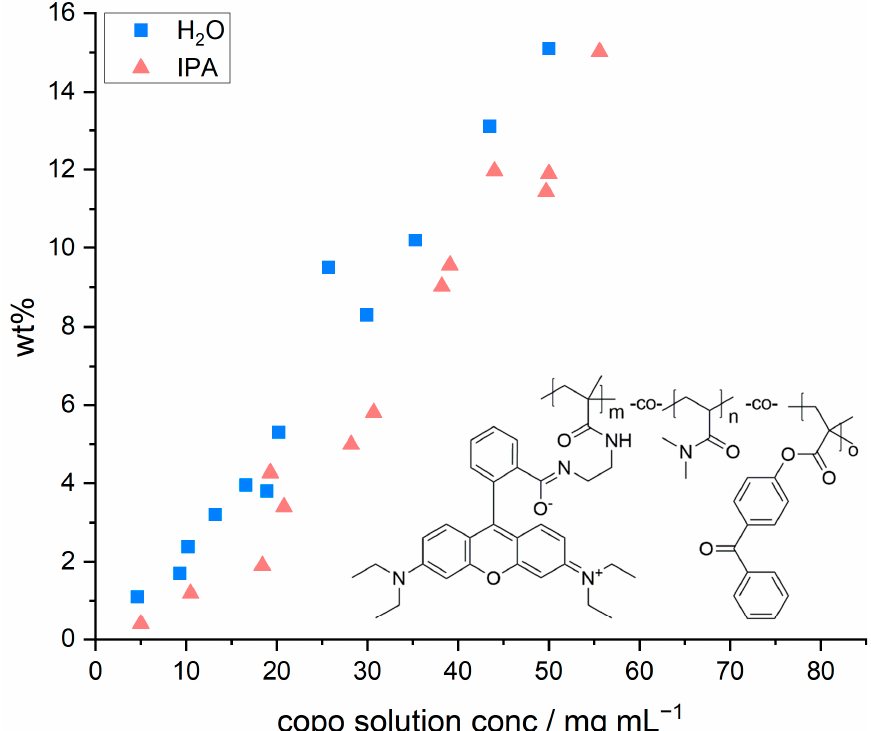
Figure 2. Gravimetrically determined amount of copolymer (compared to the paper dry weight) plotted against the concentration of the copolymer solution used for impregnating the paper sam- ples out of H 2 O (blue squares) and IPA (pink triangles), respectively. The schematic structure of the used copolymer poly(dimethylacrylamide-co-4-benzoylphenyl-2-methacrylate-co-rhodamine B-methacrylic acid (P(DMAA-co-MABP-co-RhBMA)) is shown as an inset. Next, we investigated the spatial distribution of the polymer-impregnated and cross- linked paper samples by cross-section analysis via CLSM. In Figures 3 and 4 the embedded and cut paper samples modified with different amounts of the fiber-cross-linked copolymer by impregnation from H 2 O and IPA are shown, respectively. Qualitatively, it seems that a homogeneous copolymer distribution over the z-axis was achievable only at high enough concentrations of the copolymer solution. For the lowest concentrations the majority of the fluorescence signal, indicating the copolymer, was observed in the periphery of the paper samples close to their surfaces. More specifically, the side of the paper facing upwards during the drying and UV-excitation step of the modification procedure exhibits higher amounts of copolymer if compared to the opposite side. If the concentration of the polymer-concentration was increased, this effect vanishes leading to a more homogeneous distribution of the copolymer throughout the samples. Note, the latter was observed regardless of the solvent used in the impregnation step. Taking a closer look at the CLSM data, the gradient in polymer distribution along the z-axis was significantly more pronounced for IPA-modified samples when compared to water-impregnated samples. It was observed that at the lowest concentration (see Figure 4a) the adsorption of copolymer basically only took place on the upward-facing side of the paper (left side of images). Increasing the concentration yields a sandwich-like polymer distribution with small amounts of the macromolecules being observed in the middle of the paper and the majority of the fluorescence in close vicinity to the surfaces of the sheets. The H 2 O-impregnated samples showed a similar distribution of copolymer at the lowest concentration (see Figure 3a), where transport phenomena influence the final deposition of the macromolecules. However, increasing the concentration led to a significantly more homogeneous distribution compared to the IPA-modified